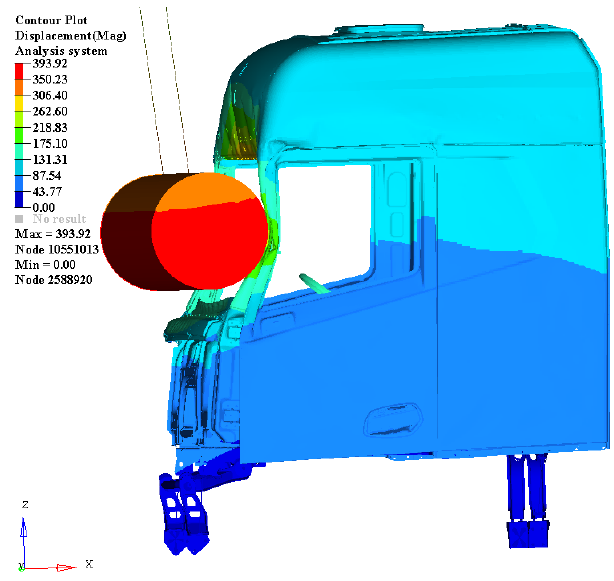
Figure 11. Deformation of the truck cab.